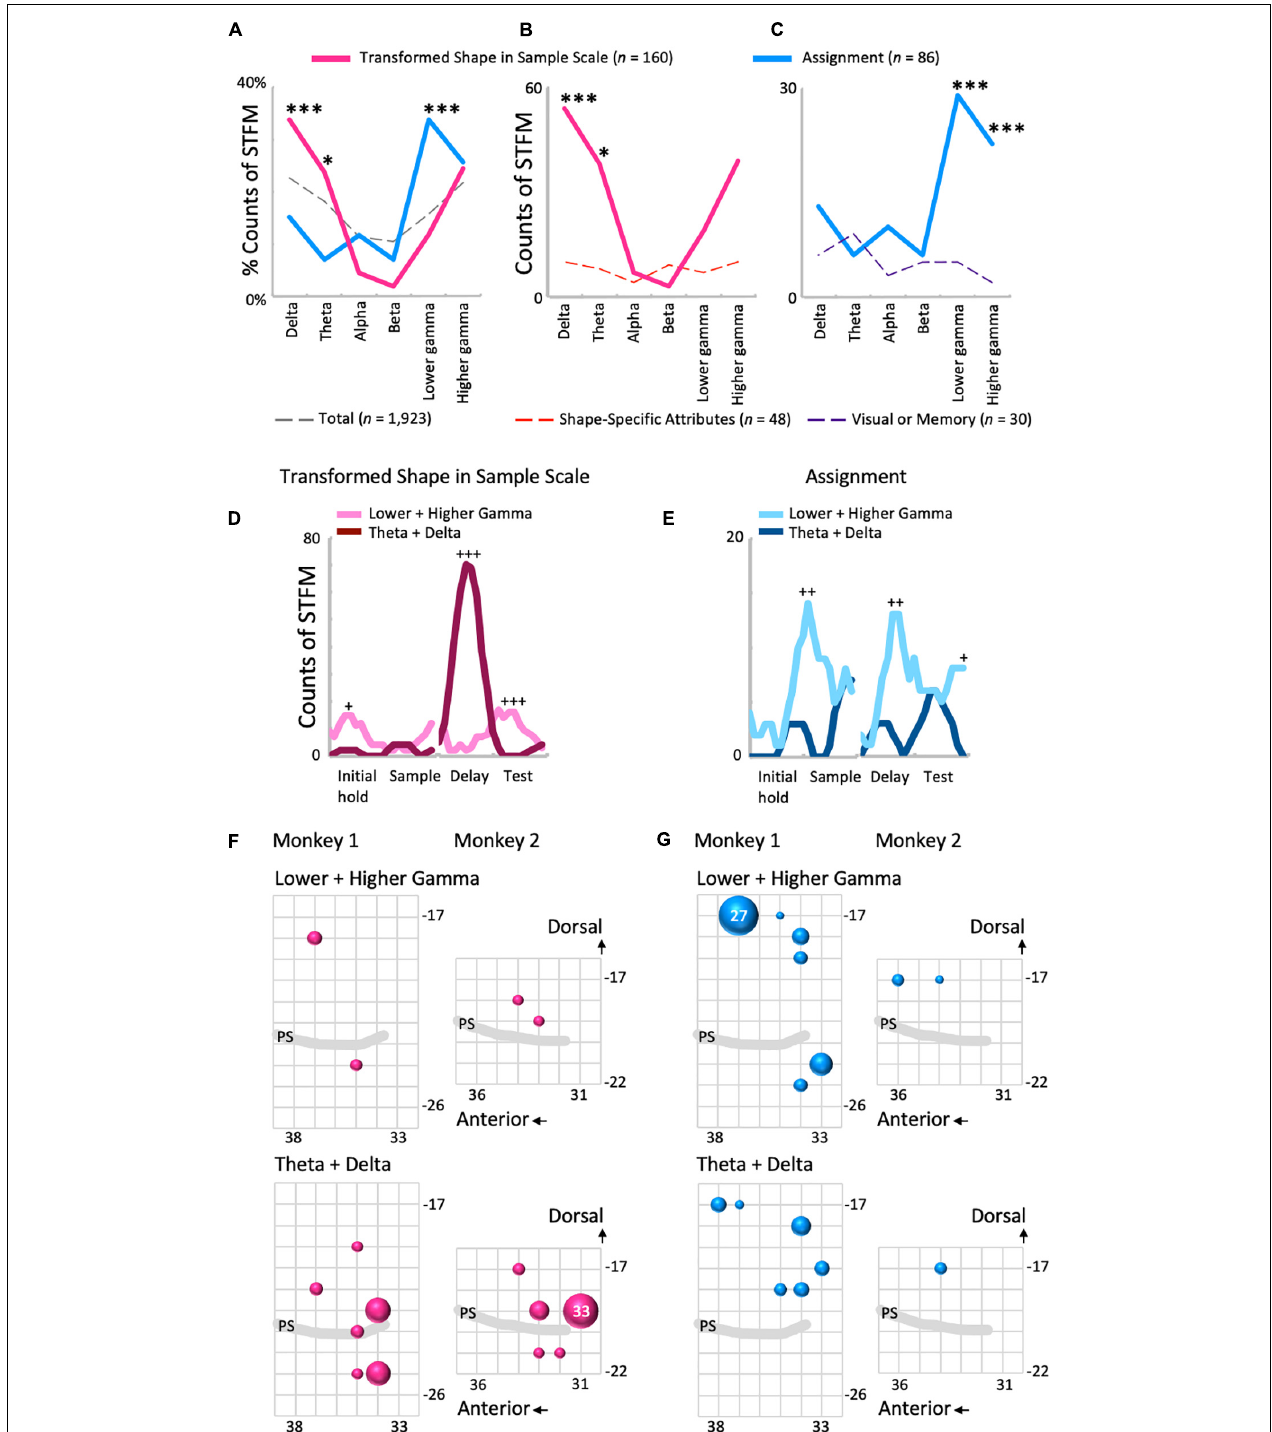
FIGURE 5 | Comparisons between the influence of shape- and rule-related predictor variables on LFP modulations. (A) The frequency distributions of the proportions of STFMs for Transformed Shape in Sample Scale (B) , Assignment, and all variables ( n = 23). (B,C) The frequency distributions of the count of STFMs for Transformed Shape in Sample Scale (B) and Assignment (C) compared to each control. ∗ p < 0.05, ∗∗∗ p < 0.001. (D,E) Time-developments of the counts of STFMs for the lower gamma and theta ranges. Transformed Shape in Sample Scale (D) and Assignment (E) . + p < 0.005, ++ p < 0.001, +++ p < 0.0001. (F) Spatial distributions of the STFMs of gamma (top) and theta-delta (bottom) ranges for Transformed Shape in Sample Scale during the delay period. The largest circle represents n = 33. (G) Same plots for Assignment. Counts are the summation of the entire preparatory period. The largest circle represents n = 27.